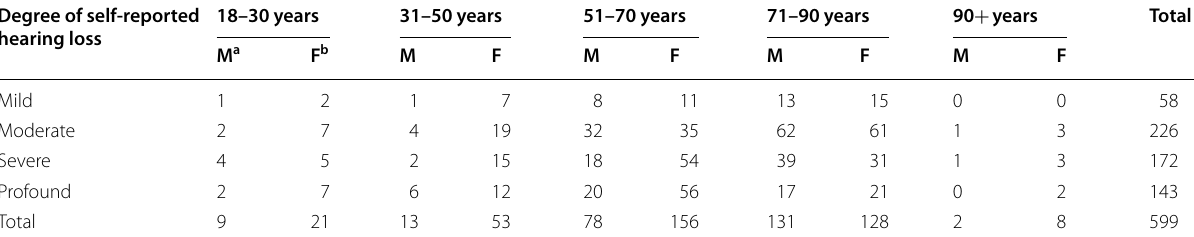
Table 1 Number of participants with each degree of self-reported hearing loss by age group and gender